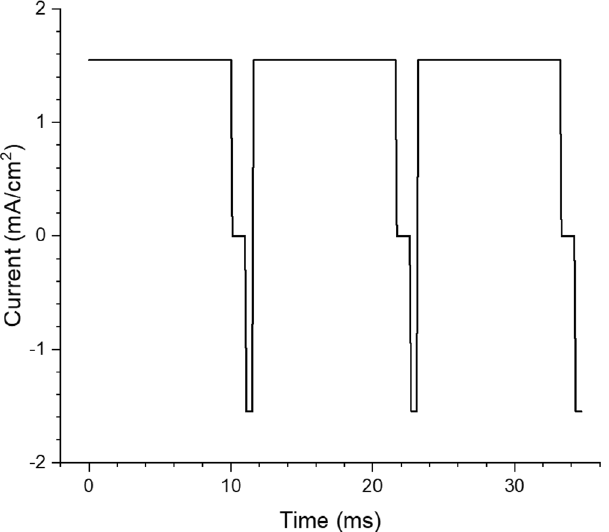
Figure 2. Waveform of the current-controlled pulsed plating process. Both the reverse and forward pulses were 1.5 mA/cm 2 .